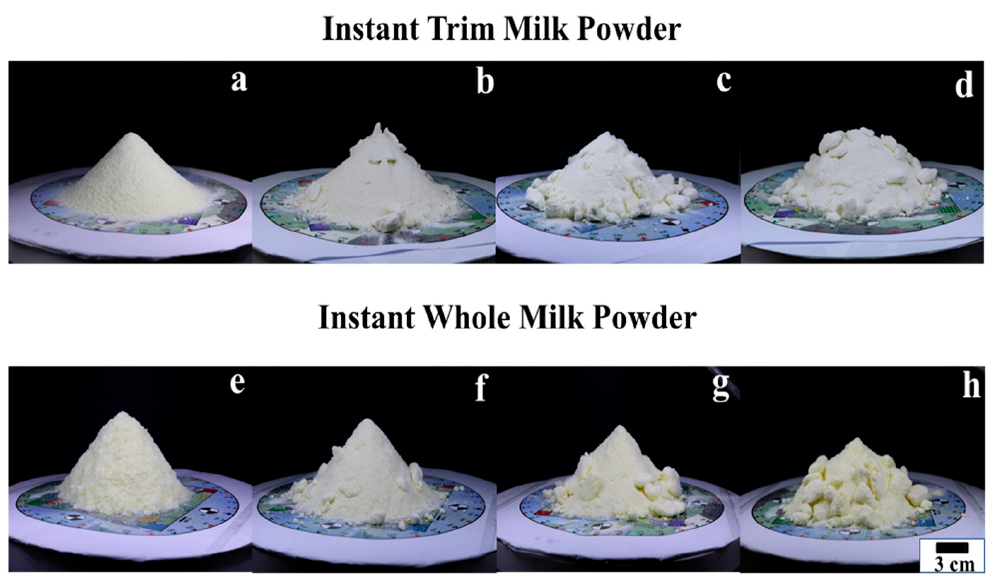
Figure 5. The front views of Class 0 ( a ), Class 1 ( b ), Class 2 ( c ), Class3 ( d ) instant trim milk powder samples and Class 0 ( e ), Class 1 ( f ), Class 2 ( g ), Class 3 ( h ) instant whole milk powder samples.